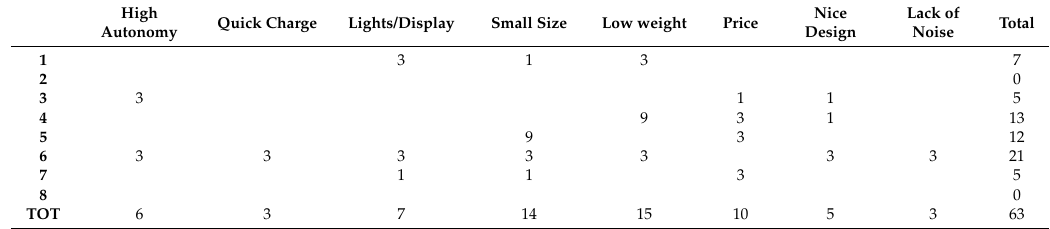
Table 5. First Use of Interrelation Matrix: Independence